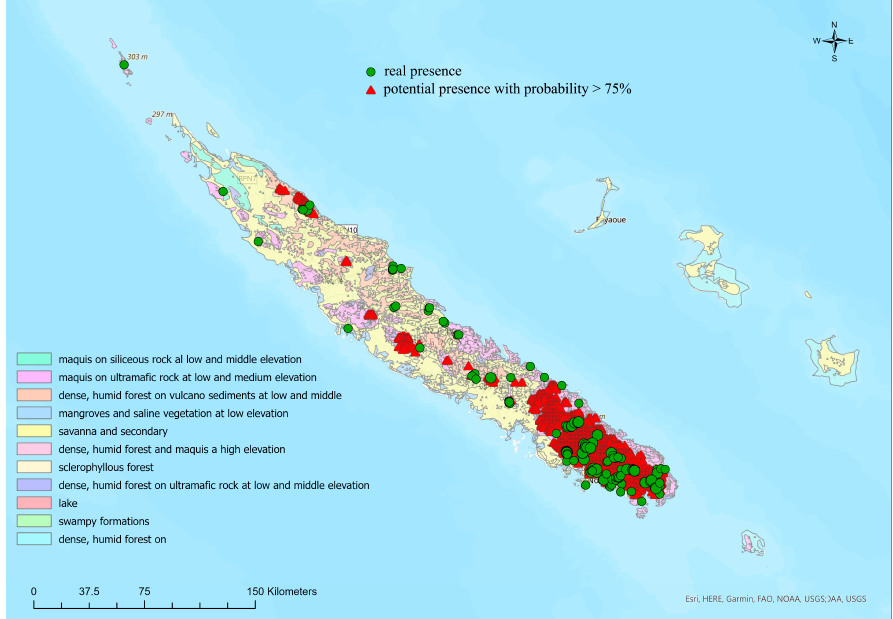
Figure 5. Potential/actual occurrence localities of Arsipoda as inferred from the ecological niche modelling process, calibrated under current climatic conditions.